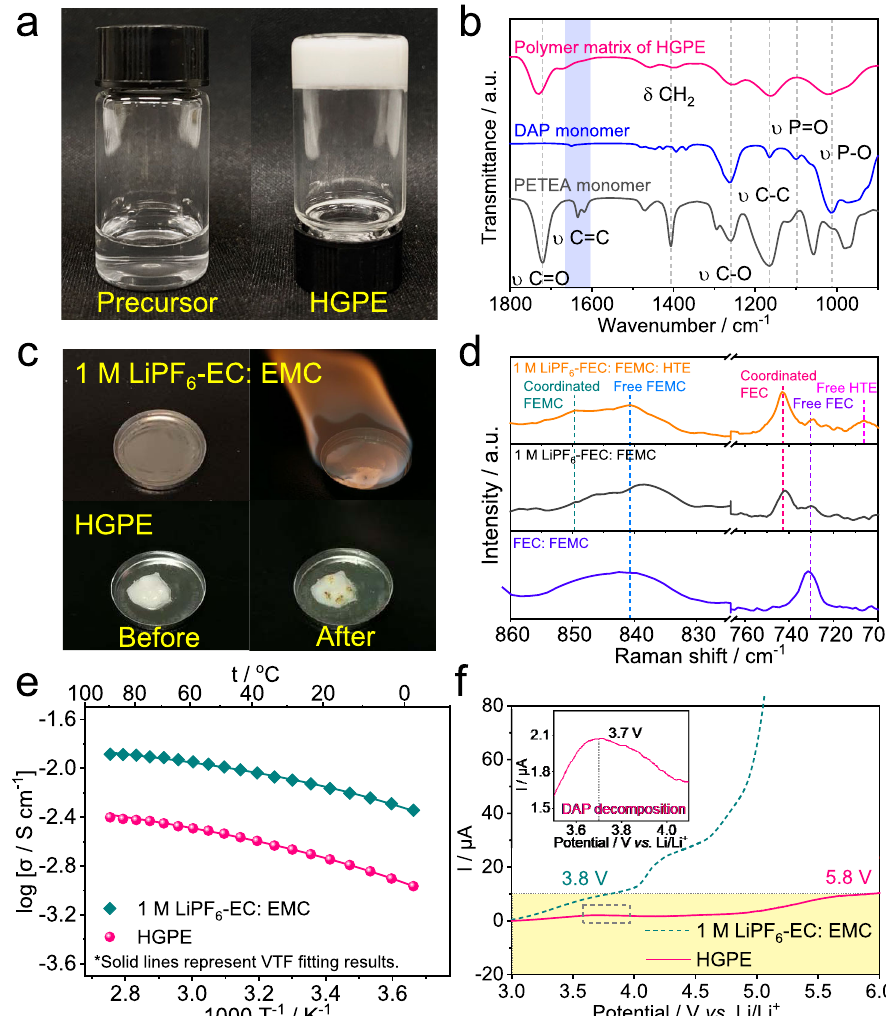
Fig. 2 Characterization of the HGPE. a Optical images of the precursor solution (left) and the corresponding HGPE (right) after copolymerization; b FTIR spectra of the DAP, PETEA, and the polymer matrix of HGPE; c Combustion tests of 1M LiPF 6 -EC: EMC electrolyte and HGPE; d Raman spectra of FEC: FEMC mixture, 1M LiPF 6 -FEC: FEMC and 1M LiPF 6 -FEC: FEMC: HTE electrolytes; e Ionic conductivities for 1M LiPF 6 -EC: EMC electrolyte and HGPE at various temperatures from 0 – 90°C. The plots represent the experimental data while the solid lines represent VTF fi tting results. f LSV curves of 1M LiPF 6 -EC: EMC electrolyte and HGPE at a scan rate of 5mVs − 1 , using platinum foil as the working electrode and Li foil as the counter and reference